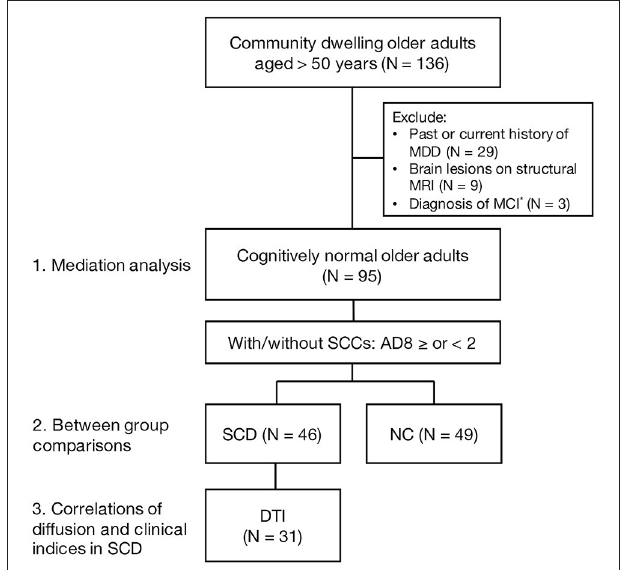
FIGURE 1 | A flow chart of enrollment. MDD, major depressive disorder; MCI, mild cognitive impairment; SCCs, subjective cognitive complaints; SCD, subjective cognitive decline; NC, normal control; DTI, diffusion tension imaging. *MCI diagnosis was based on the MoCA score lower than one standard deviation below the age- and sex-adjusted